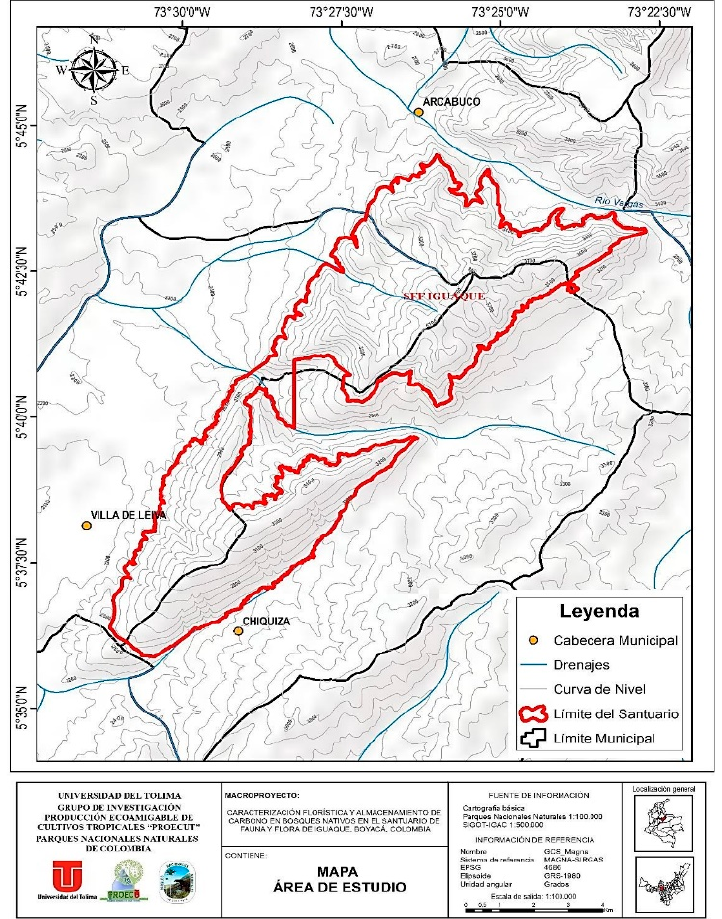
Figure 1. Location of the study area, Santuario de Flora y Fauna Iguaque (SFFI), Boyacá, Colombia. Source: PROECUT Research Group.